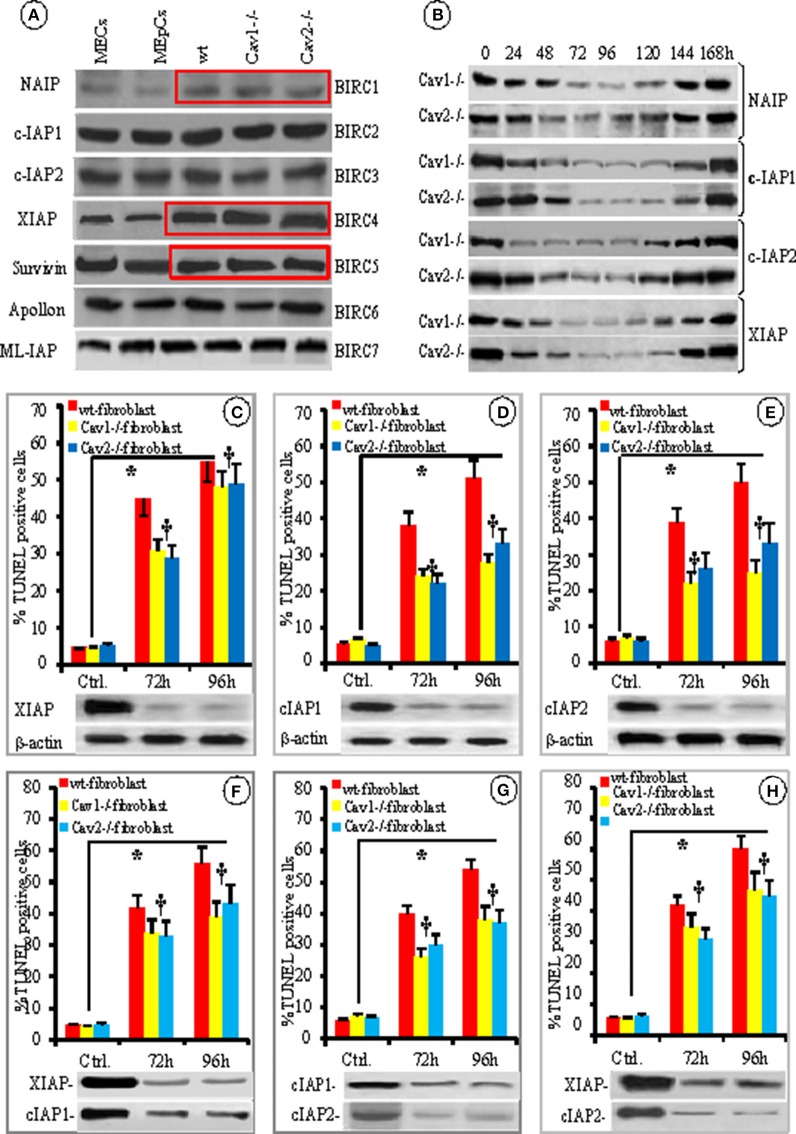
IAPs involvement in fibroblast resistance to apoptosis. (A) Representative WB using specific Abs for different IAPs protein expression in the mouse lung cells–ECs, EpCs, wt-, Cav1−/− and Cav2−/− fibroblasts, as indicated; n = 6 for each IAP. (B) The time course and transient nature of siRNA-mediated knockdown of four BIRCs: NAIP, cIAP1, cIAP-2, and XIAP- in Cav-null fibroblasts; n = 4 for each IAP and Cav-null fibroblasts. The effects of individual knockdown as indicated–XIAP (C), cIAP1 (D) and cIAP2 (E), n = 4 experiments for every type of fibroblasts and every time point, *p < 0.05 between controls and cav –null fibroblasts but †p < 0.1 in between Cav1−/− and Cav2−/− fibroblasts. The combined knockdown–XIAP/cIAP1 (F), cIAP1/cIAP2 (G), and XIAP/cIAP1 (H) effects in fibroblasts resistance to FasL-induced apoptosis; n = 6, *p < 0.05 when compared to untreated fibroblasts.